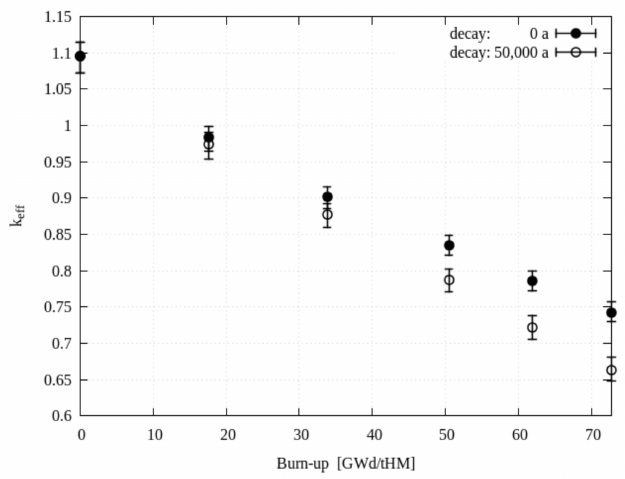
Figure 4. Keff values obtained with the consistent ND-UQ approach. Data points show the average of 200 BUCSS-R executions performed for every BU step. Error bars span over the entire range of calculated keff